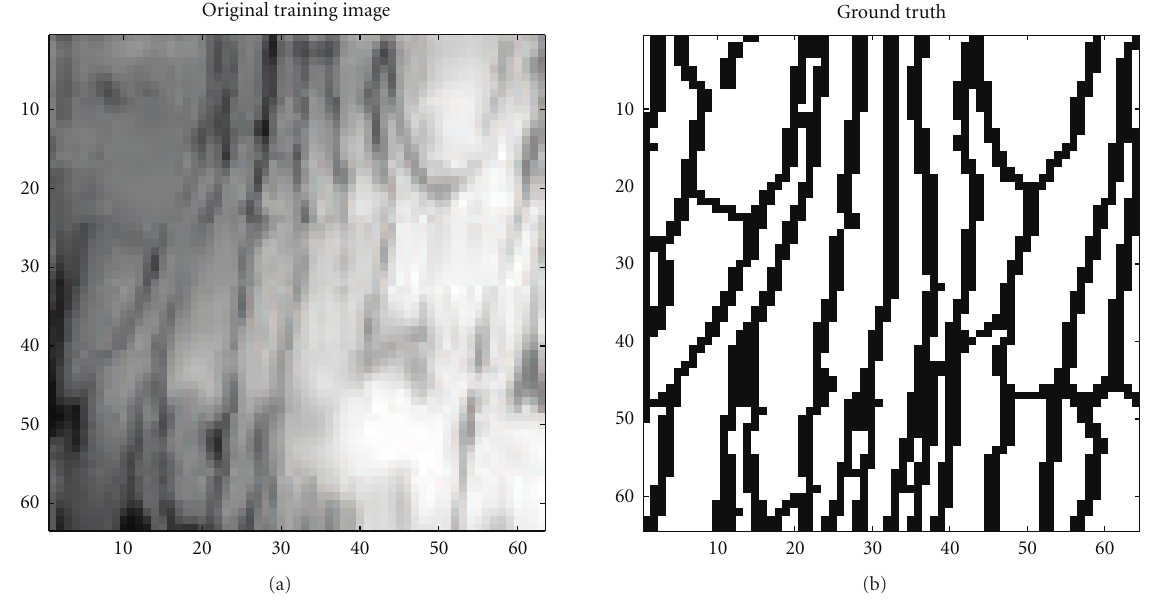
Figure 6: Original training image with its corresponding manually traced ground-truth image.